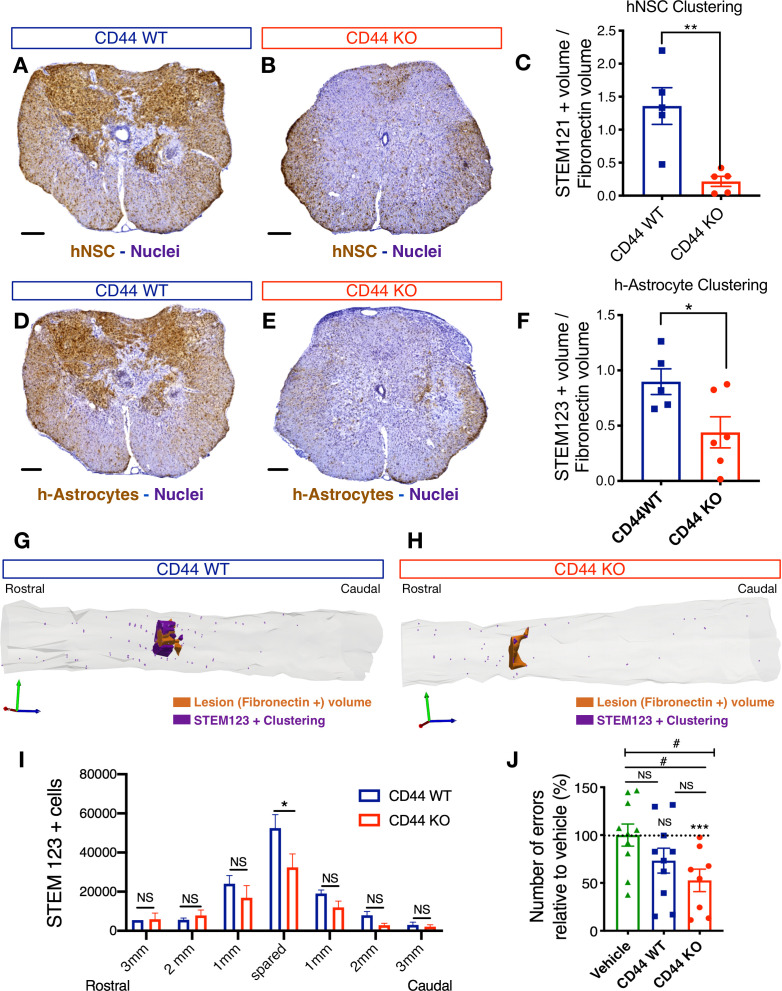
CD44 KO decreases hNSC localization at the SCI epicenter, modulating astroglial fate and rescuing the capacity of hNSC to promote locomotor recovery after transplantation into the acute SCI microenvironment.All histological data obtained 16 weeks post-transplant (WPT). (A,B) Representative images of transverse spinal cord sections corresponding to the injury epicenter area immunostained for the human-specific cell marker STEM121 (brown; scale bars, 250 µm) and hematoxylin nuclear counterstain (purple) on spinal cords from mice transplanted with WT (blue) or CD44 KO (red) hNSC. (C) Stereological analysis of STEM121+ human cell clustering using Cavalieri sampling demonstrates a decrease in CD44 KO vs. WT human cells adjacent to the SCI epicenter. Data show mean ± SEM (N = 5–6 mice randomly selected for histology/group). Statistical analysis using Student’s t-test as indicated (**p≤0.01). (D,E) Representative image of transverse spinal cord section corresponding to the injury epicenter area immunostained for the human astrocyte specific marker STEM123 (brown; scale bars, 250 µm) and hematoxylin nuclear counterstain (purple) in spinal cords from mice transplanted with (D) WT or (E) CD44 KO hNSC. (F) Stereological analysis of STEM123+ h-astrocyte clustering using Cavalieri sampling demonstrates a decrease in CD44 KO vs. WT h-astrocytes adjacent to the SCI epicenter. Data show mean ± SEM (N = 5–6 mice randomly selected for histology/group). Statistical analysis using Student’s t-test as indicated (*p≤0.05). (G,H) Representative three-dimensional reconstructions generated by stereological quantification of the lesion Fibronectin+ area (orange volume), STEM123+ clusters (purple volume), and individual STEM123+ cells (light purple dots) from mice transplanted with CD44 WT or KO hNSC. (I) Stereological analysis of STEM123+ h-Astrocyte number in the spared tissue adjacent to the SCI epicenter demonstrates a decrease in CD44 KO vs. WT localized in these regions. Data show mean ± SEM (N = 5–6 mice randomly selected for histology/group). Statistical analysis using Student’s t-test as indicated (*p≤0.05). (J) CD44 KO in hNSC rescues the capacity of acutely transplanted hNSC to promote locomotor recovery. Mice transplanted acutely with CD44 KO but not WT hNSC made significantly fewer errors on the horizontal ladder beam locomotor task in comparison with vehicle-treated mice 16 WPT. Data shown as number of errors normalized to vehicle-treated mice (dashed line; N = 8–10 mice/group). Statistical analysis using one-sample t-test (NS, not significant, ***p≤0.0005) for comparison with control vehicle-treated mice and via one-way ANOVA (#) p<0.05 followed by Tukey’s post-hoc t-test as indicated (NS, not significant; #p≤0.05) for comparison between conditions.